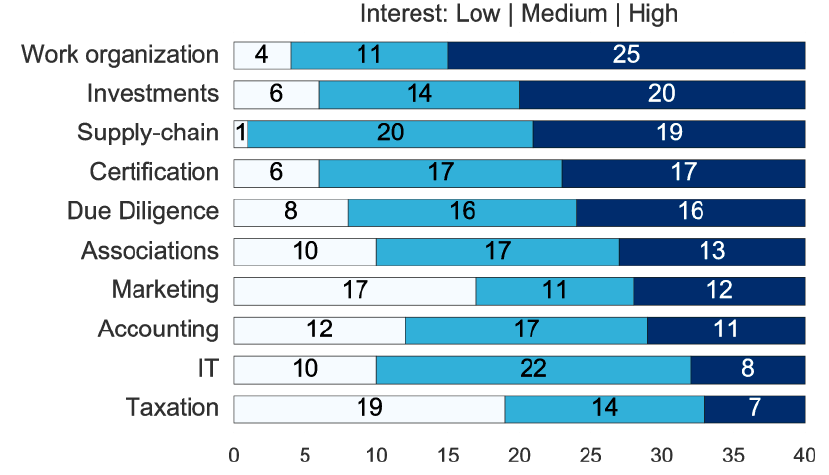
Figure 3. Stakeholder preference regarding entrepreneurial training.